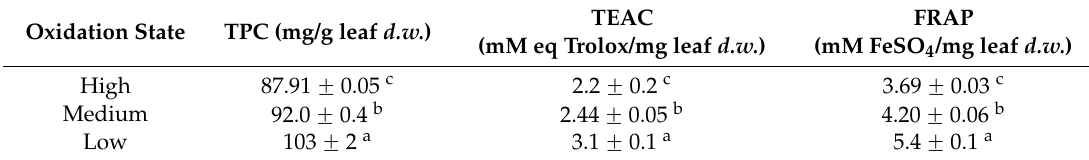
Table 3. Comparison (mean ˘ SD, n = 3) among total phenolic content (TPC) by HPLC-DAD-ESI- QTOF-MS, Trolox Equivalent Antioxidant Capacity (TEAC) and Ferric Reducing Antioxidant Power (FRAP) of Psidium guajava L. leaves at different oxidative